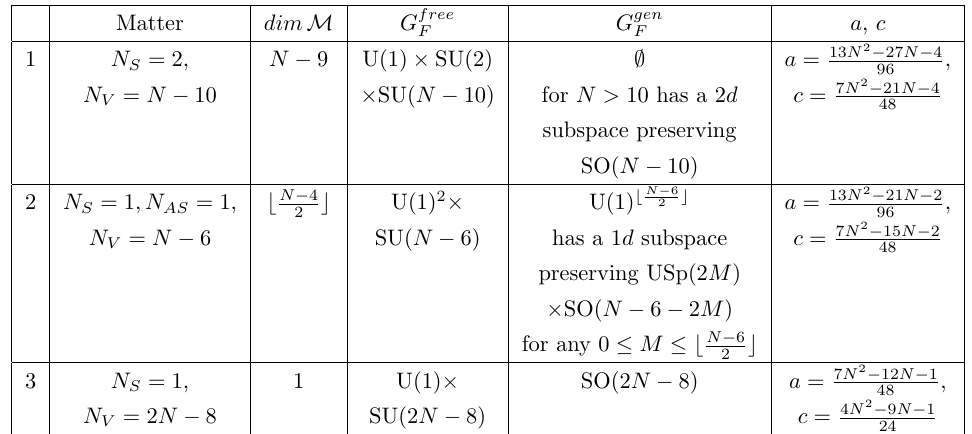
Table 18 . Cases involving an SO( N ) gauge group with ‘generic’ matter.